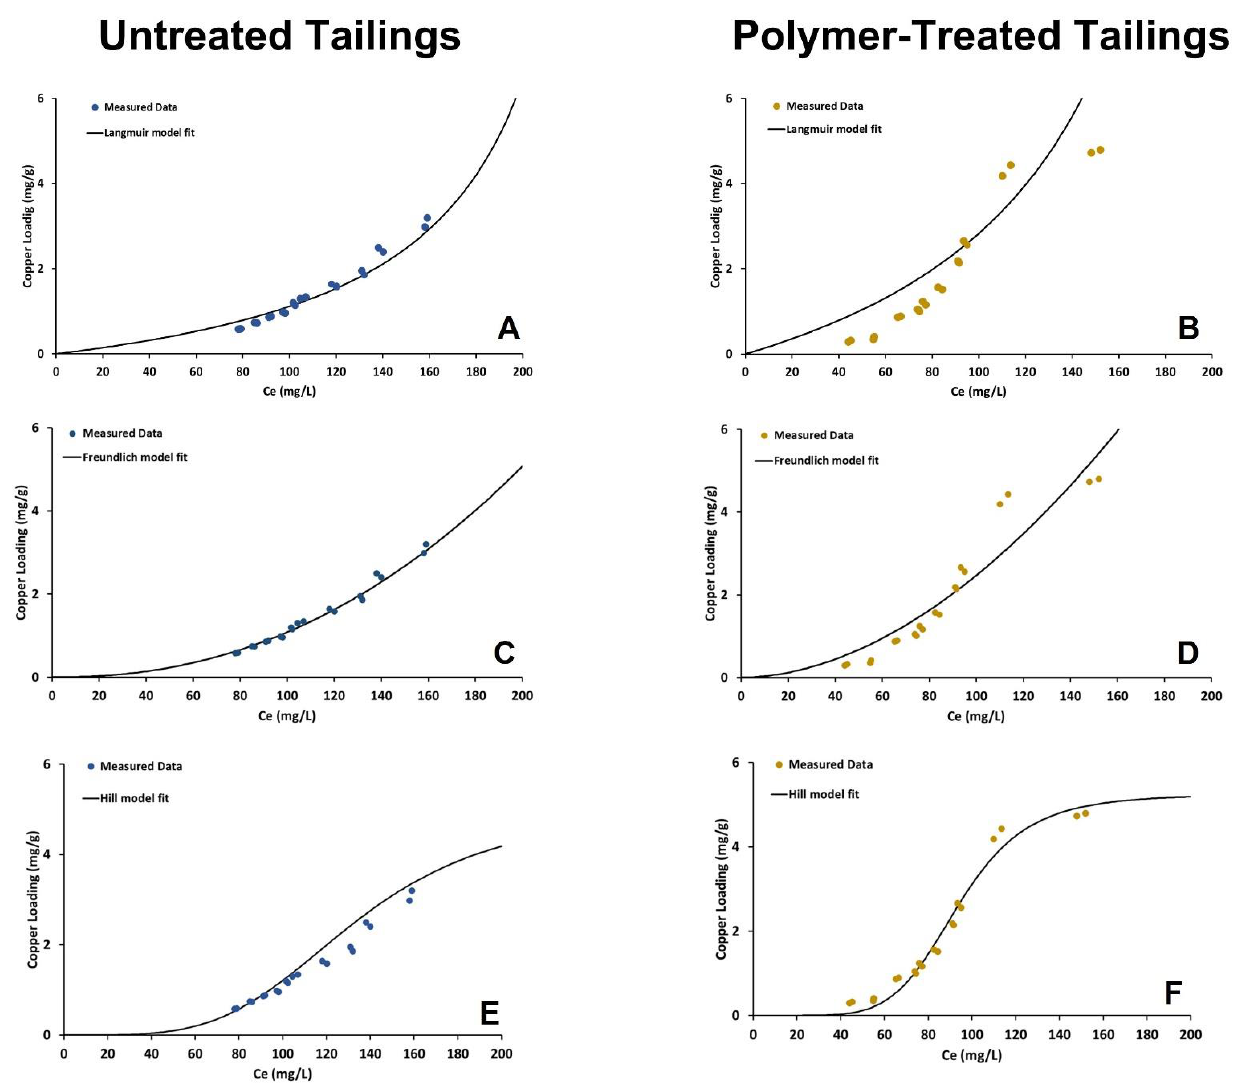
Figure 7. Non-linear least squares (NLLS) model fits for copper ion sorption for untreated and polymer treated materials. ( A ) Langmuir model fit-UT, ( B ) Langmuir model fit-PT, ( C ) Freundlich model fit-UT ( D ) Freundlich model fit-PT, ( E ) Hill model fit-UT, ( F ) Hill model fit-PT.